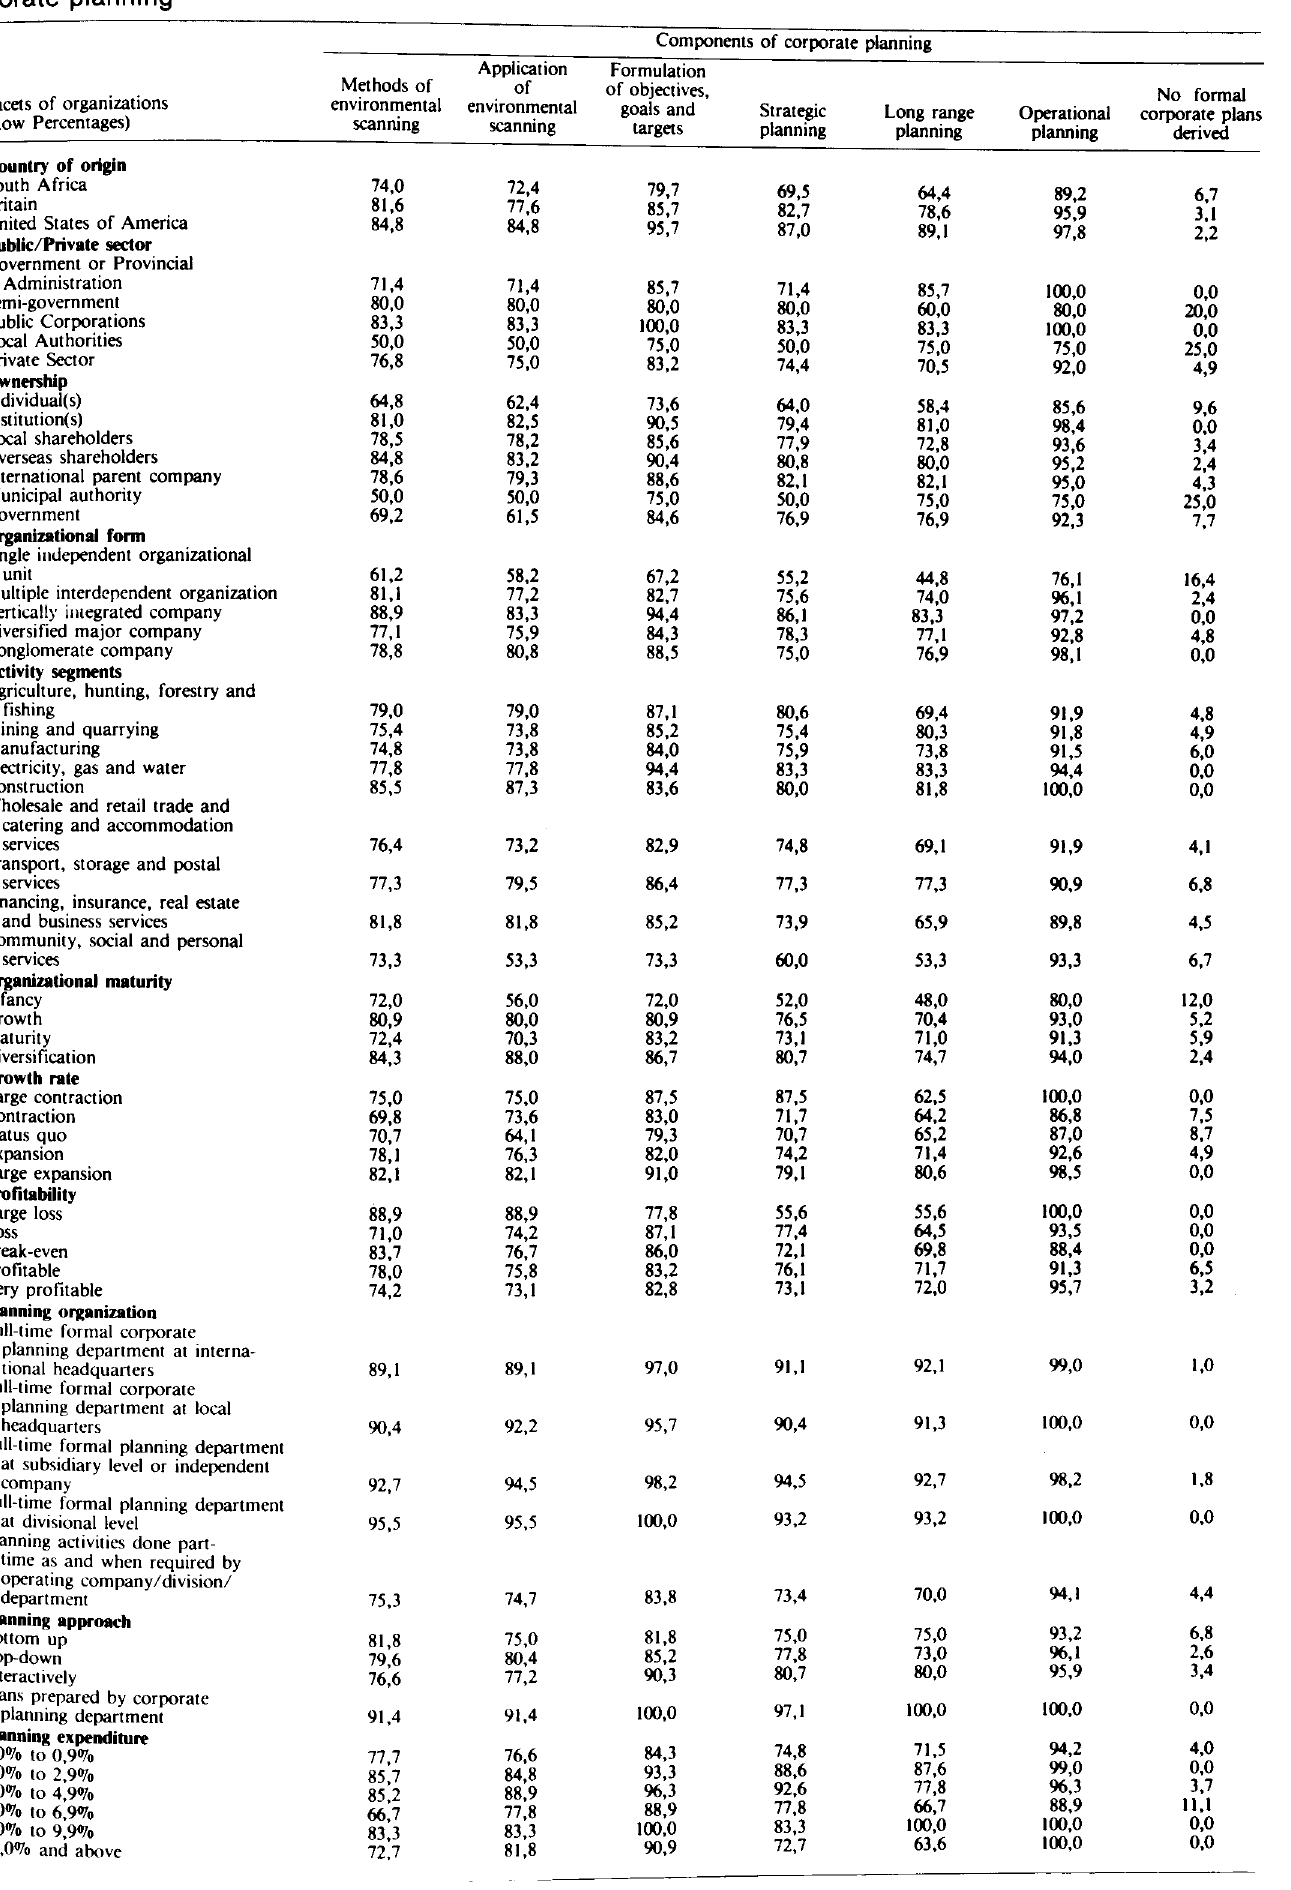
Table 1 Percentages of miscellaneous facets of organizations which undertake the various components of cor porate planning Components of corporate planning Application Formulation Methods of of of objectives, No formal Facets of organizations goals and Strategic Long range Operational scanning targets planning planning planning